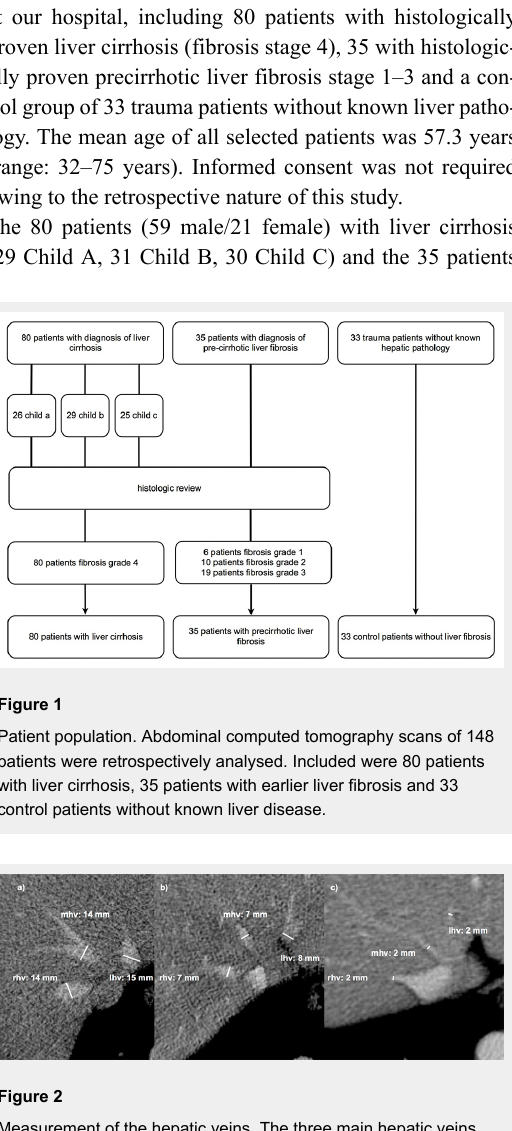
Measurement of the hepatic veins. The three main hepatic veins were measured 1–2 cm before their aperture into the inferior caval vein. Accessory veins were not included. (a) normal liver,(b) liver fibrosis grade 2, (c): liver cirrhosis Child b. rhv, mhv, lhv = right, middle and left hepatic vein diameters.